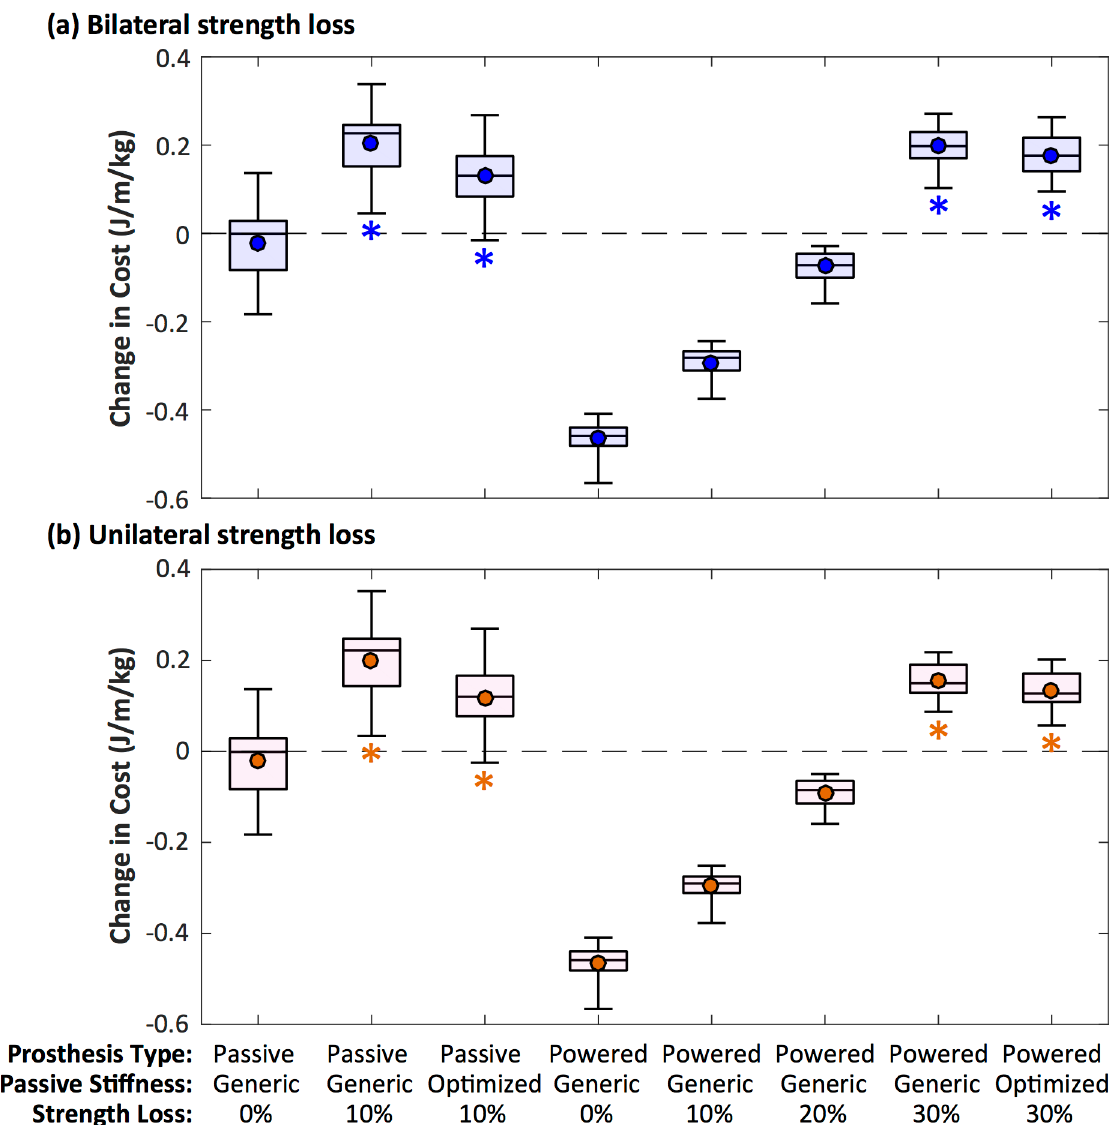
Fig 7. Changes in gross metabolic cost. Box plots of changes in metabolic cost of walking at 1.3 m/s (relative to the pre-limb loss simulation) for different prosthesis types, passive prosthetic ankle stiffness, and level of strength loss. Panel (a) is simulations of bilateral strength loss. Panel (b) is simulations of unilateral strength loss, on the side of the residual limb. The symbol within each box is the mean. (cid:3) indicates the change was significantly greater than zero ( p < 0.001, d > 1.0, B > 100).